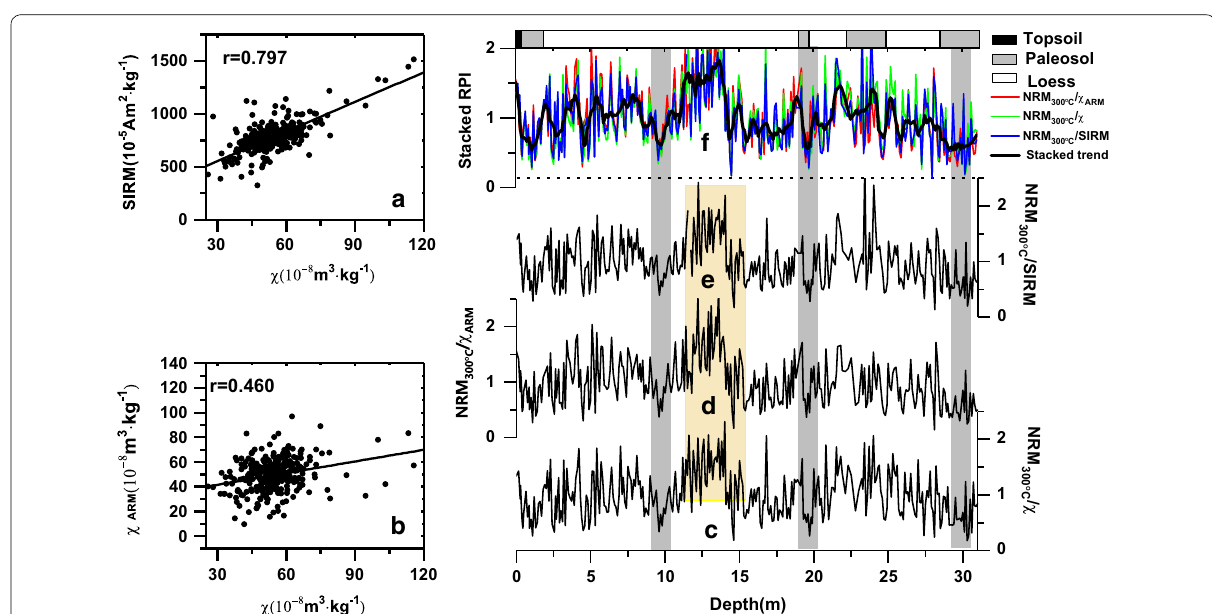
Fig. 6 Relative paleointensity (RPI) curves related to three magnetic concentration parameters. a , b Binary analysis of magnetic concentration parameters used in the RPI acquisition. c – e RPI curves obtained with different normalizers. f Stacked RPI in the BYH section. Gray bars highlight the RPI